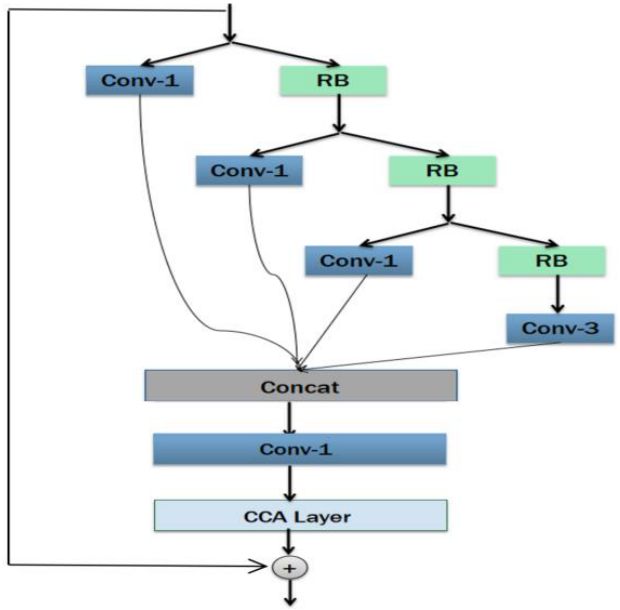
Figure 3. The architecture of RIDB.